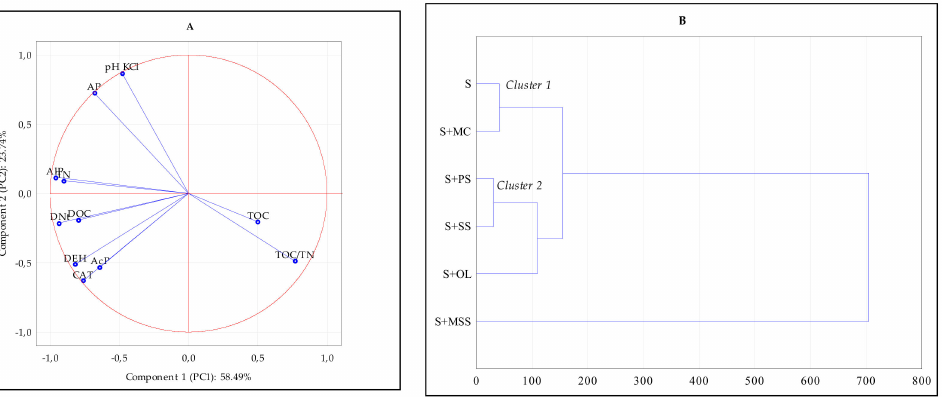
Figure 4. Configuration of variables in the system of the first two axes, PC1 and PC2, of principal components ( A ); cluster analysis ( B